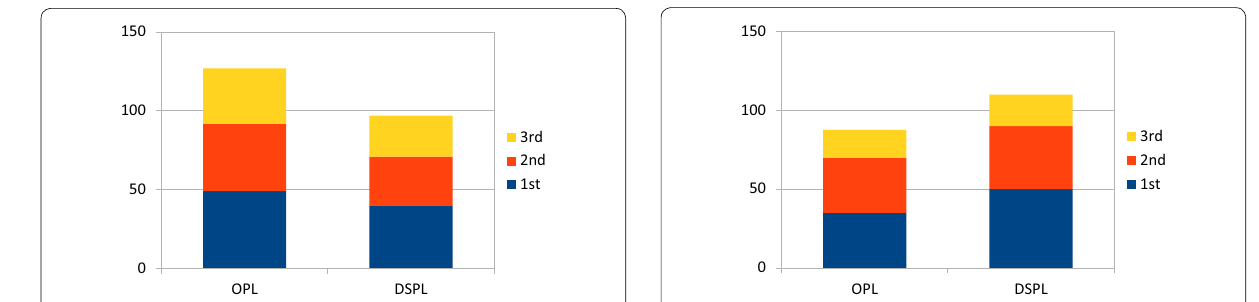
Fig. 28 Total points of top three teams for GPSR in 2018 (Obtained from [49])